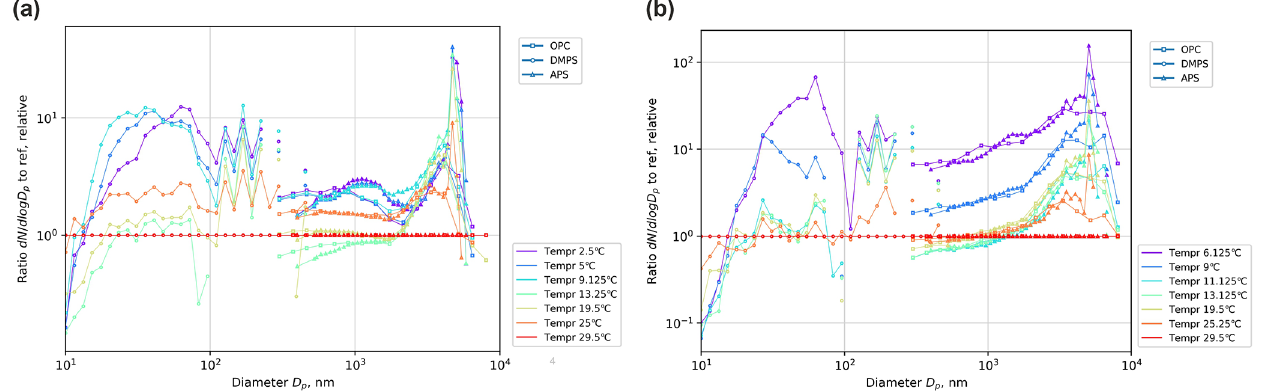
Figure 8. Water temperature effect on particle size spectrum for salinity S = 0.1M (a) and S = 0.6M (b) . In both panels, the spectra for differ- ent temperatures are normalized with the spectrum at T = 29.5 ◦ C and the corresponding salinity. Color legends present mean temperatures of the experiments.